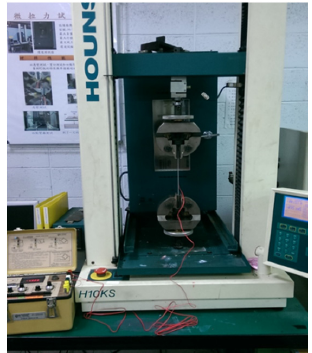
Figure 4. Experimental setup of the tensile test.